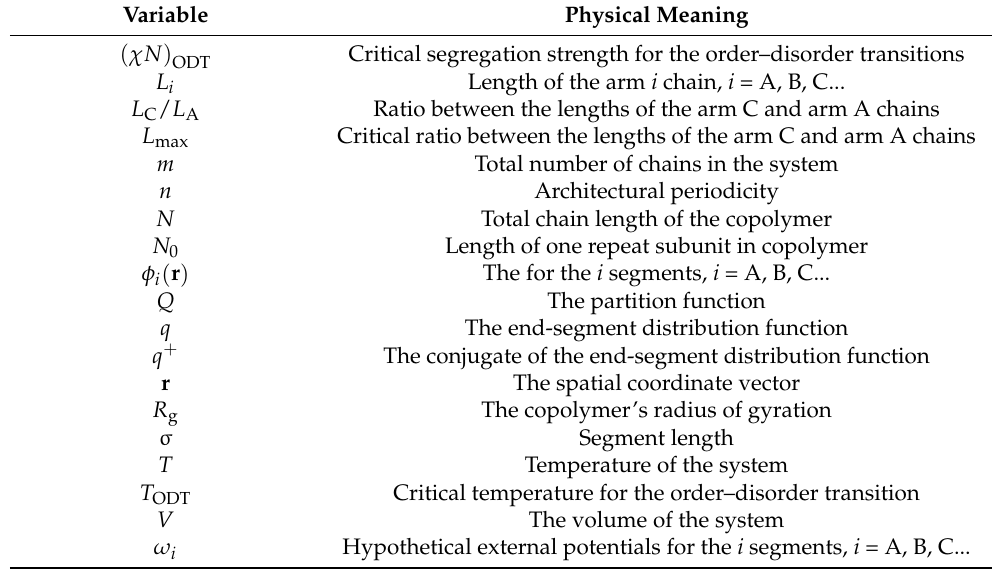
Table A2. Cont. Variable Physical Meaning ( χ N ) Critical segregation strength for the order–disorder transitions ODT Length of the arm i chain, i = A, B, C... Ratio between the lengths of the arm C and arm A chains Critical ratio between the lengths of the arm C and arm A chains Total number of chains in the system Architectural periodicity Total chain length of the copolymer